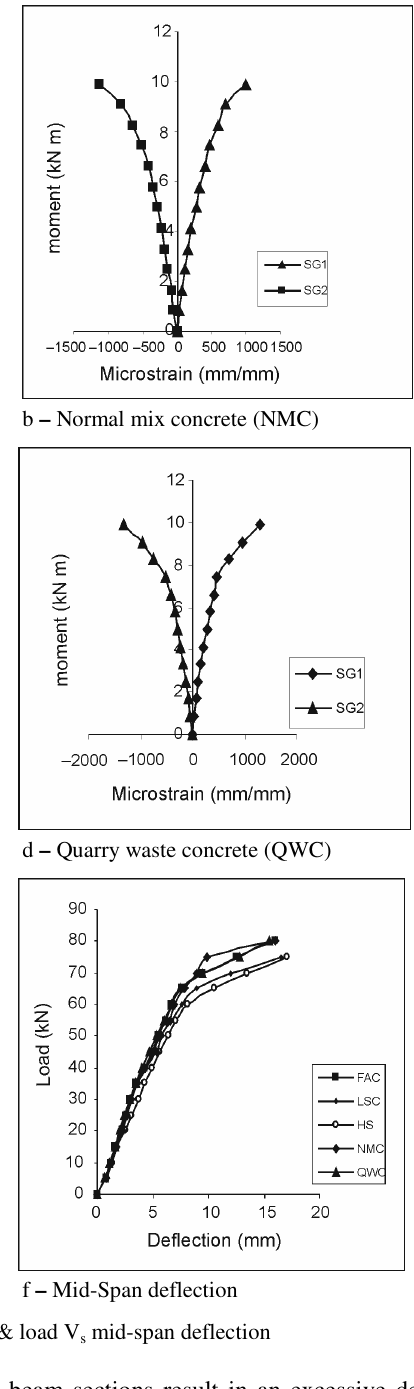
Fig. 7. Square section: moment V s strain & load V s mid-span